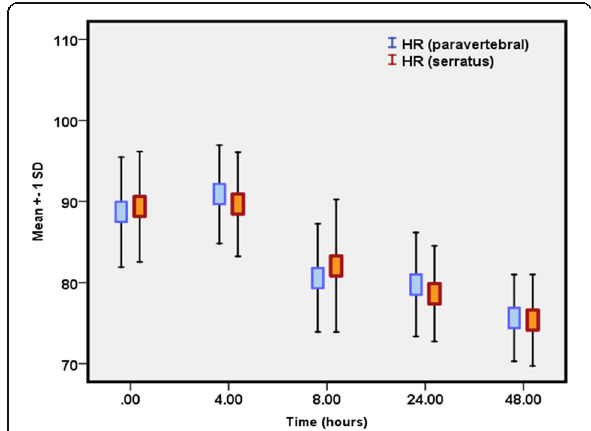
Fig. 3 Heart rate (HR) in beats/min both